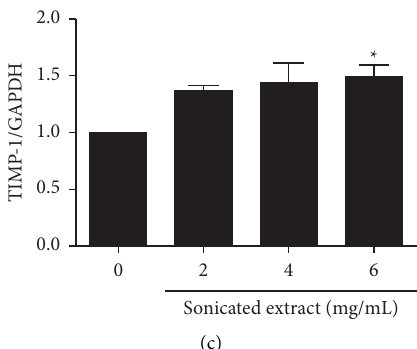
Figure 6: Te efect of the sonicated extract on the expression of protein regulators in cancer cell migration. PC-3 cells were treated with the sonicated extracts at 0, 2, 4, and 6mg/mL for 24h. Te protein expression levels of MMP-9 and TIMP-1 were evaluated using a Western blot assay. (a) Te expression of MMP-9 and TIMP-1 normalized to the GAPDH loading control. (b–c) Te relative band intensity was quantifed by Image software. Data are presented as the means ± SEM ( n � 3). p < 0 . 05 ∗ was compared with the control group by one-way ANOVA (Dunnett’s